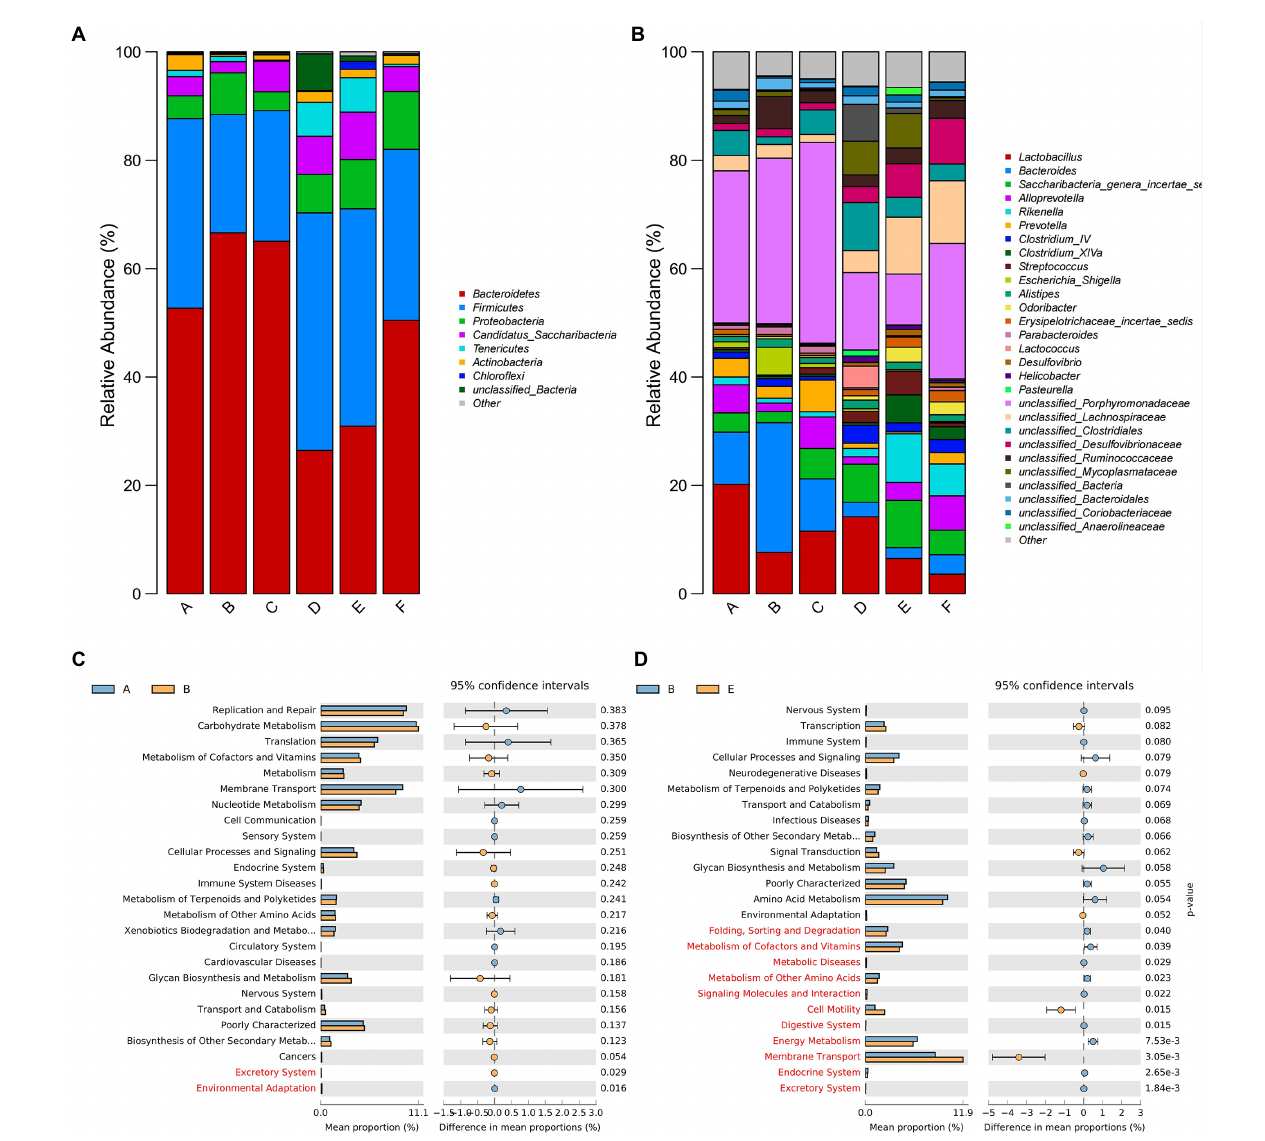
FIGURE 4 Microbial community composition (A) phylum levels. (B) Genus levels. The different Metabolic pathways prediction (C) Control vs. ETEC K88. (D) ETEC K88 vs. CYN.H. In the picture, A represents Control group, B represents ETEC K88 group, C represents CYN. L group, D represents CYN. M group, E represents CYN. H group, and F represents BTW